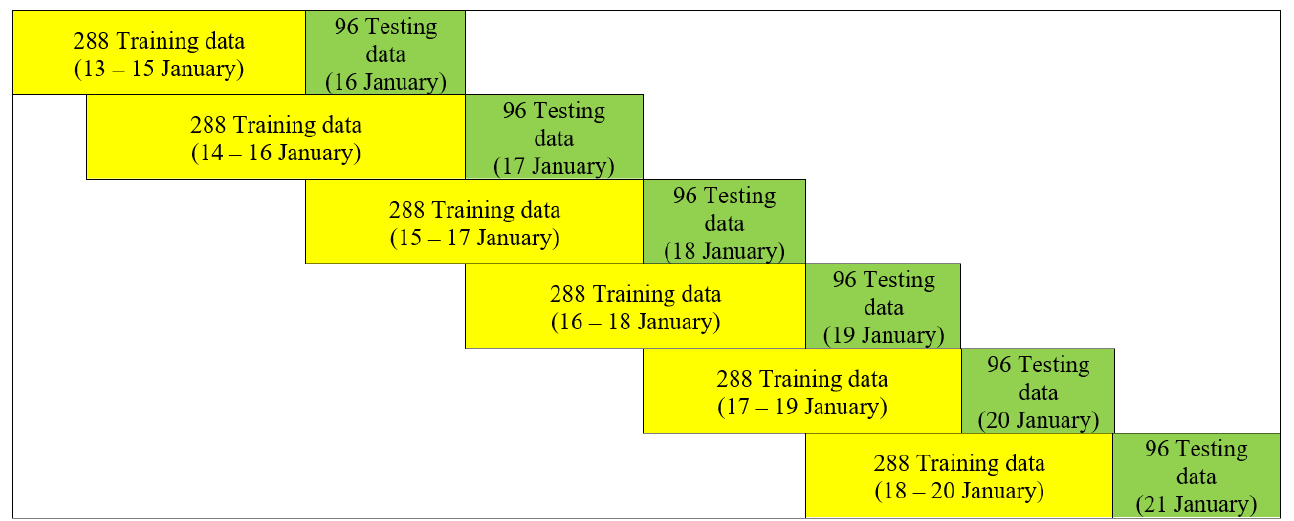
Figure 7. Training and testing data sets with sliding window technique from 13–21 January for the prediction of T ma and T ahc .